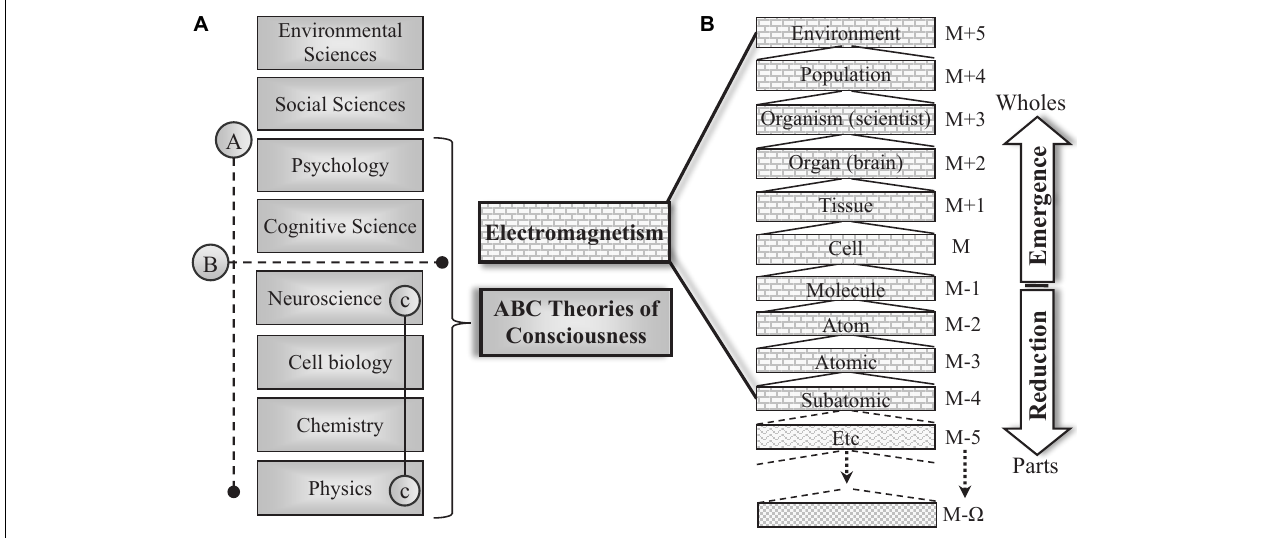
FIGURE 2 | (A) The organizational hierarchy of sciences in the lineage relevant to the study of the brain, consciousness, cognition, intelligence, and behavior. Line A shows the hierarchy of the sciences tackling consciousness. Line B depicts the upper boundary of the physical sciences. Line C shows the connection between neuroscience and the standard model of particle physics that is central to Parts I and II. (B) The natural hierarchy identified by scientists beneath line B. Each layer of description is constructed from within the hierarchy by scientists within layer [M + 3]. The specific case shown leads deep into the ultra-structure of the notional brain of the particular observing/describing scientist. Each layer is a collection of weakly emergent “wholes” comprised of members of all the layers below. Based on Hales (2014, Figure 10.1). See also Feinberg (2011, Figure 7) and Bongard and Levin (2021, Figure 1) and hierarchy theory in general (Koestler, 1967, 1978; Grobstein, 1973; Pattee, 1973; Simon, 1973; Allen and Starr, 1982; Salthe, 1985; Ahl and Allen, 1996).